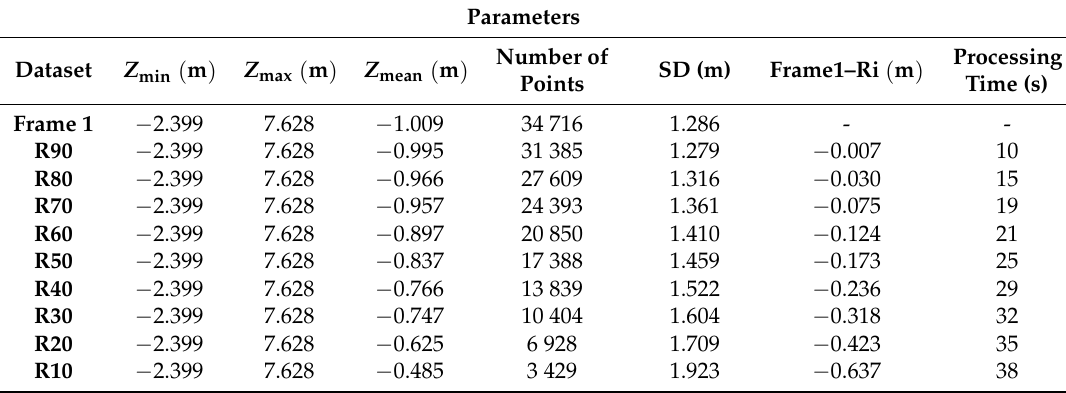
Table 1. Characteristics of obtained datasets after the OptD-single-MLS method for Frame